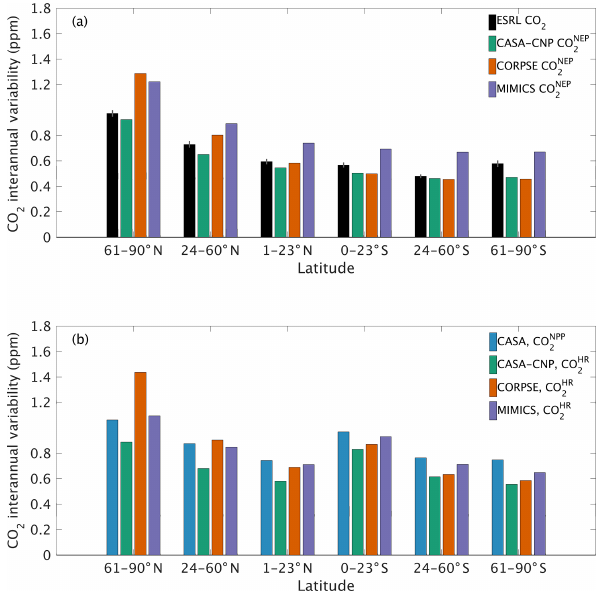
Figure 6. Magnitude of CO 2 interannual variability resulting from (a) net ecosystem productivity and (b) component fluxes. Observed CO 2 IAV from the NOAA ESRL network is shown with black bars whereas colors represent simulated data. Error bars shown on the observed IAV represent 2 standard deviations, calculated as the me- dian magnitude after removing a 12-month sliding window from the IAV time series.